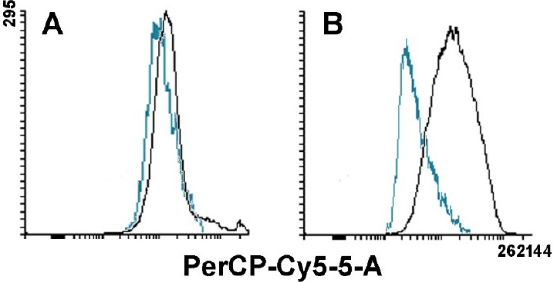
Figure 6. Representative plots showing AVO accumulation in MDA-MB231 cells exposed to crude extracts (( A ); 9.16 µ g / mL) and 10K fractions (( B ); 8.34 µ g / mL) for 48 h (black peaks). The blue peaks correspond to the untreated cell preparations. The x -axis reports the intensity of red fluorescence emitted by the dye acridine orange, which is proportional to the amount of intracellular AVOs.